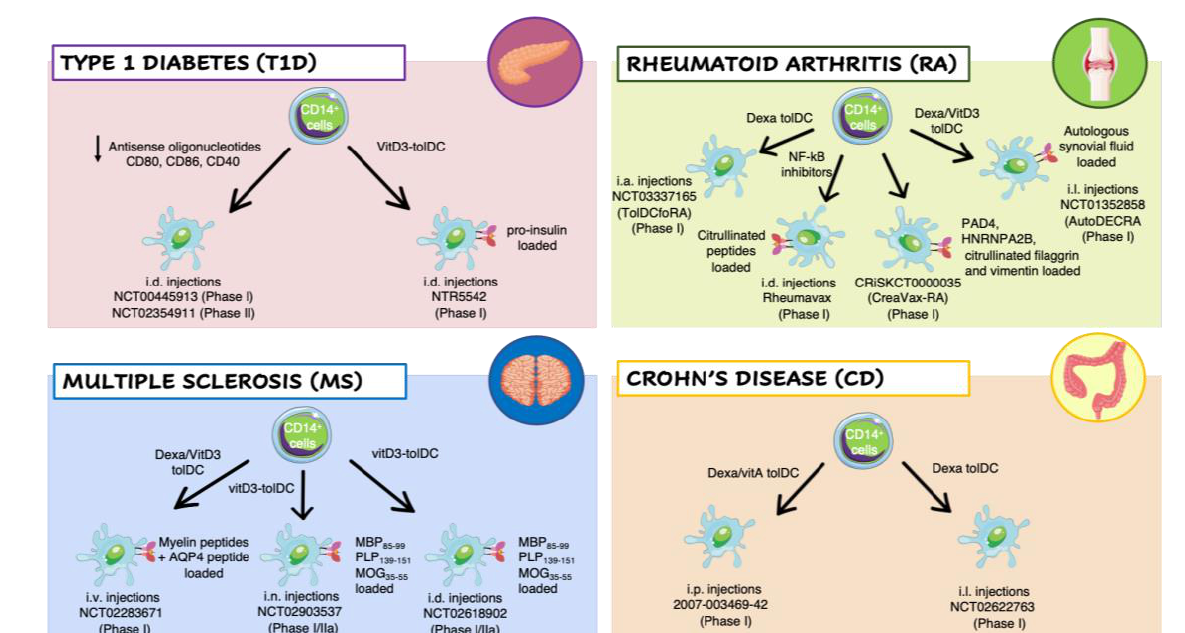
Figure 2. Clinical trials employing ex vivo generated tolerogenic DCs (tolDCs). TolDCs were differentiated starting from patients’ CD14 + monocytes in the presence of different tolerogenic agents. The resulting cells have been tested in clinical trials for different autoimmune diseases: Type 1 Diabetes (T1D) (pink panel), Rheumatoid Arthritis (RA) (green panel), Multiple Sclerosis (MS) (blue panel), and Crohn’s Disease (CD) (orange panel). Abbreviations: Dexa, Dexametasone; VitD3, 1,25-dihydroxyvitamin D3; VitA, vitaminA; NF-kB, nuclear factor kappa-light-chain-enhancer of activated B cells; AQP4, acquaporin-4; MBP 85–99 , Myelin Basic Protein; PLP 139–151 , proteolipid protein; MOG 35–55 , myelin oligodendrocyte glycoprotein; PAD4, peptidyilarginine deaminase 4; HNRNPA2B, heterogeneous nuclear ribonucleoprotein A2/B1; i.v., intravenous; i.n., intranodal; i.d., intradermal; i.p., intraperitoneal; i.l., intralesional; i.a., intra-articular.